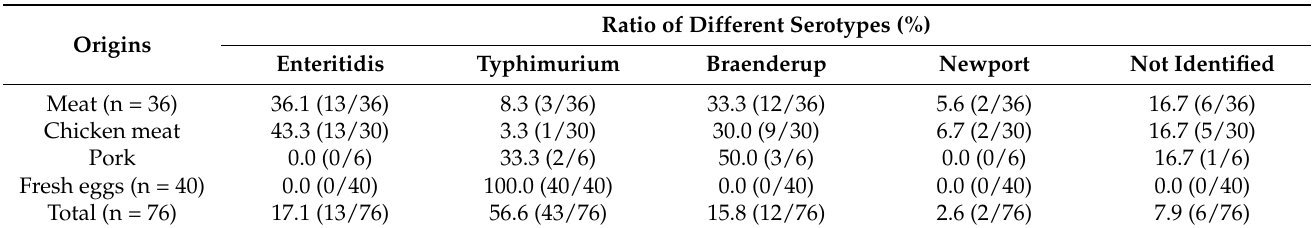
Table 2. Distribution of the serotypes of 76 Salmonella isolates in retail food from different sources.